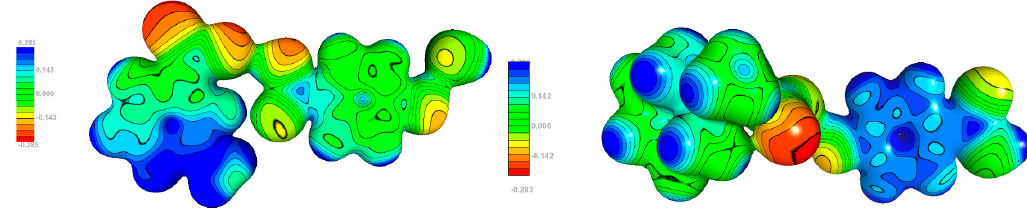
Figure 14. Experimental electrostatic potential mapped onto 0.1 isodensity surfaces of molecule 1 ( left ) and 2 ( right ).